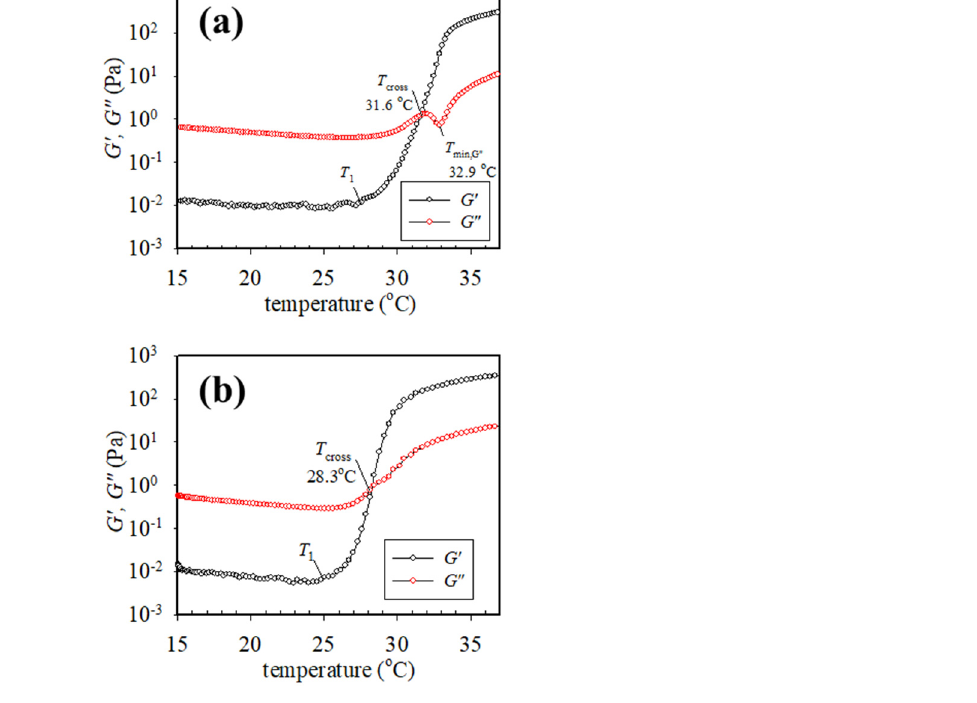
Figure 5. Temperature dependence of G ′ and G ″ curves of the 5.5 wt% a-PNIPAM solution during a temperature sweep test at a heating rate of ( a ) 0.2 °C/min, and ( b ) 2.0 °C/min.